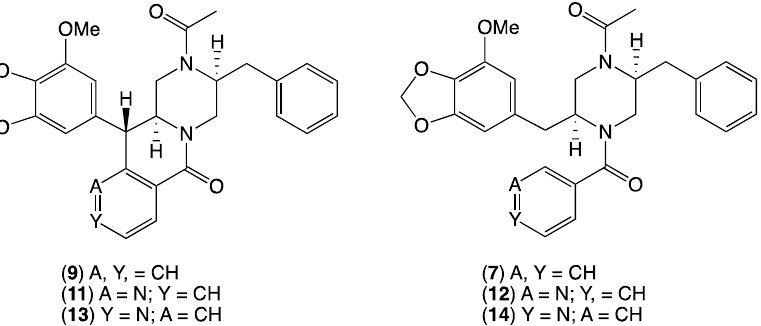
Figure 5. Diagnostic 2D NMR (DMSO- d 6 ) correlations for 1 , 3 and 5 .